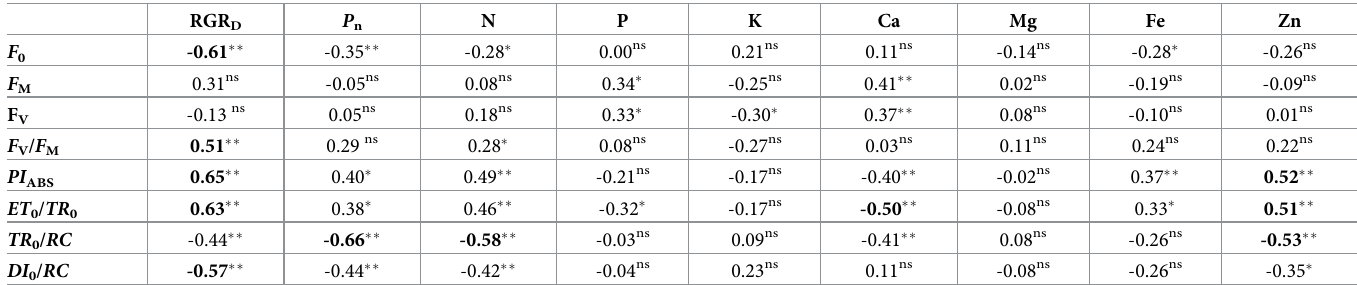
Table 3. Pairwise Spearman correlation coefficients ( r S ) among ChF variables and growth, photosynthesis and foliar nutrient concentrations. RGR